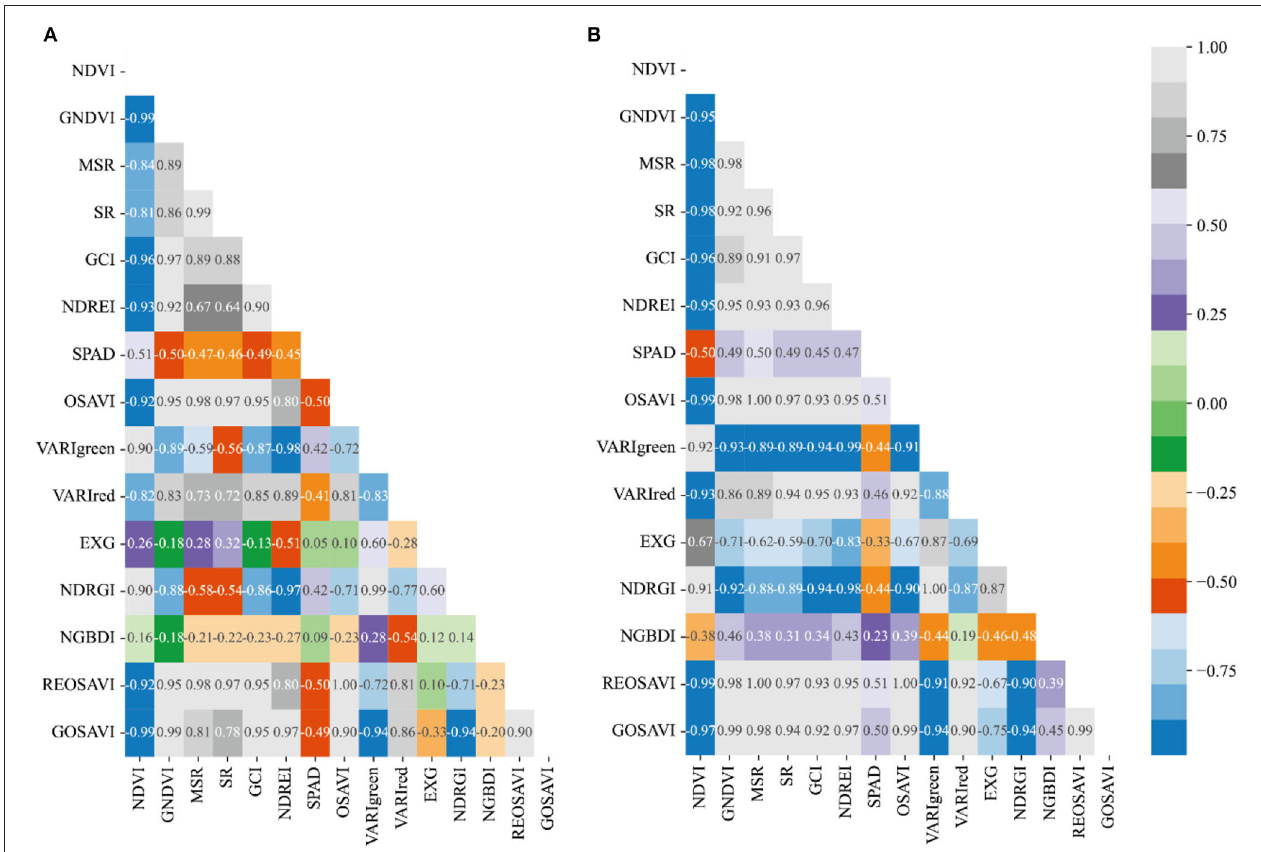
FIGURE 8 | Plot of correlation between different vegetation indices and CC of winter wheat during the filling period: (A) Normal treatment of Manas winter wheat during the filling period, and (B) Water treatment of Manas winter wheat during the filling period. All vegetation indices that appear in the figure are explained in Table 3 .